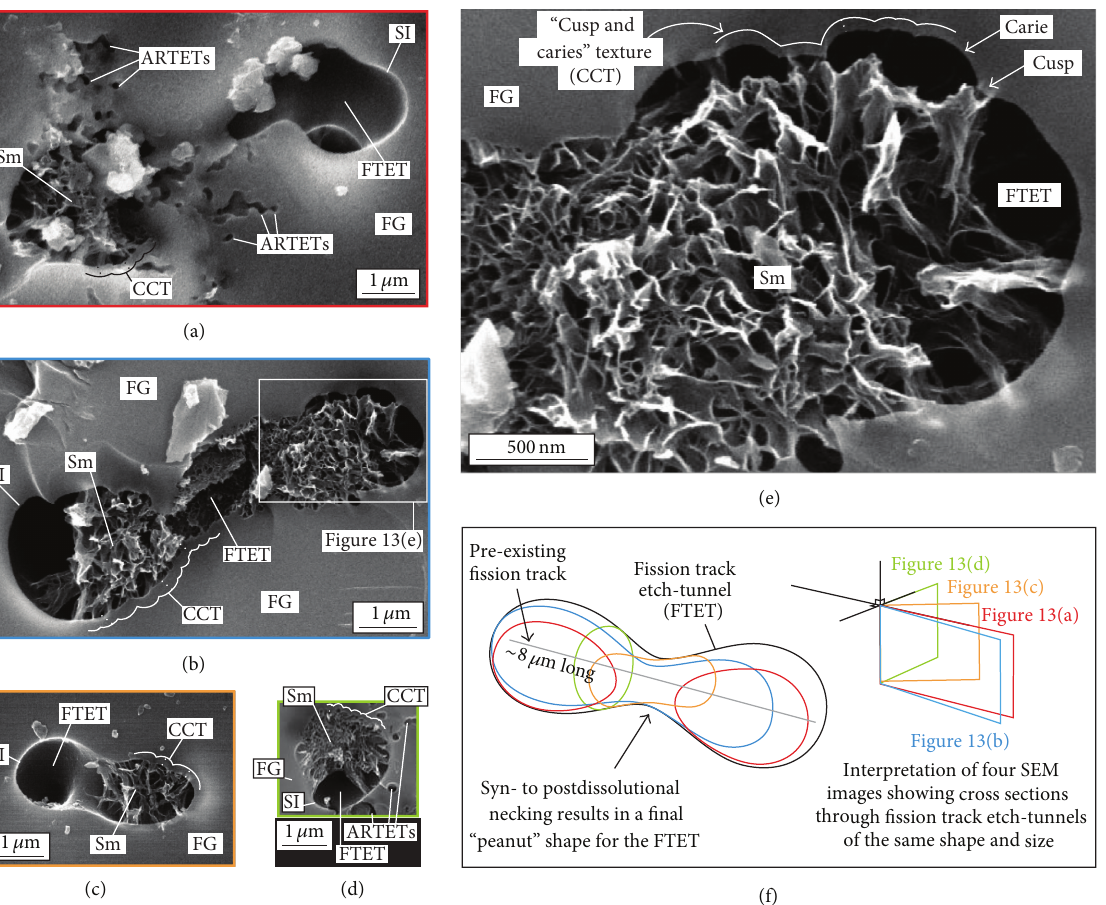
Figure 13: High resolution SEM (secondary electron) imaging of fission track etch-tunnels (FTETs) at the glass-palagonite interface (as observed on the freshly fractured surfaces of basaltic glass “chip samples” of DSDP-418A-75-3[120–123] ). (a–d) Images of four FTETs shown at the same scale, all of which contain authigenic platy smectite. Note how two of these FTETs ((a) and (d)) are interconnected to several smaller ARTETs as a part of the same porosity/etch-tunnel network. In addition, all four FTETs exhibit two contrasting types of glass-dissolution interface: (1) a smooth interface (labelled “SI”) at regions distal to secondary smectite growth and (2) a “cusp and caries” textured interface (labelled “CCT”) at regions undergoing dissolution in the vicinity of secondary smectite growth (see Figure 14 for further explanation of CCT). (e) Close-up from (b), highlighting authigenic platy smectite within an FTET, as well as well-developed cusp and caries microtexture. (f) Interpretation of the four large etch-tunnels shown in (a–d) as variably oriented cross sections through FTETs of essentially the same shape and size (i.e., peanut-shaped and ∼ 8 𝜇 m long). ARTETs: alpha-recoil track etch-tunnels; CCT: “cusp and caries” texture; FTET: fission track etch-tunnel; SI: smooth interface; Sm: platy